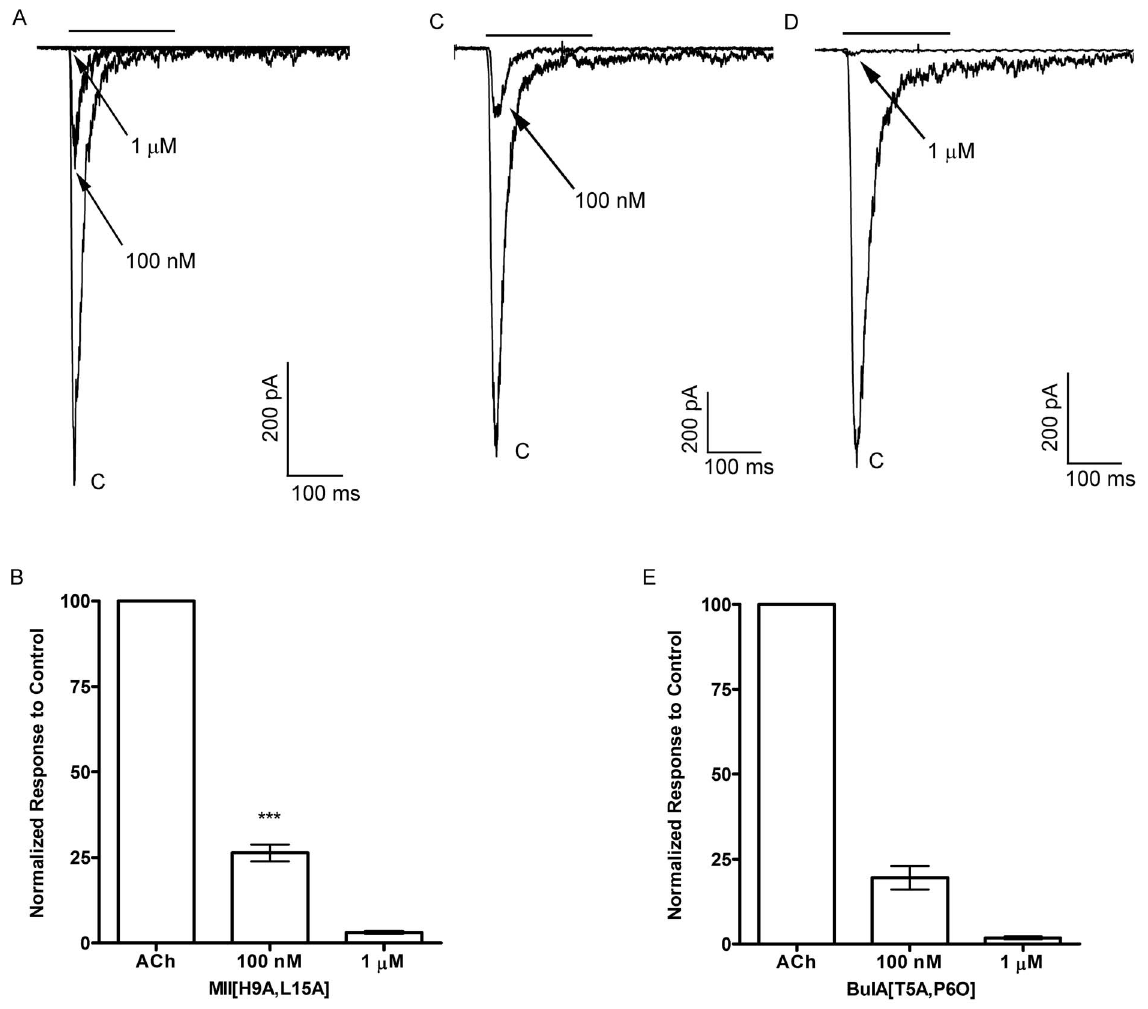
Figure 5. a -Ctx MII[H9A,L15A] and BuIA[T5A,P6O] potently inhibit the ACh-evoked currents in monkey chromaffin cells. A, Representative trace recordings of ACh-evoked currents and the inhibition by 100 nM and 1 m M MII[H9A,L15A]. B, Quantitative analysis of the inhibition by 100 nM (n=5) and 1 m M MII[H9A,L15A] (n=4). Error bars show average values 6 S.E.M (n=5); asterisks denote statistical significance (*** p , 0.001) as determined by a one sample t-test. C,D, Trace recordings of ACh-evoked currents and the inhibition by 100 nM and 1 m M BuIA[T5A,P6O]. E, Quantitative analysis of the inhibition by 100 nM (n=2) and 1 m M BuIA[T5A,P6O] (n=4); error bars show average values 6 S.E.M.